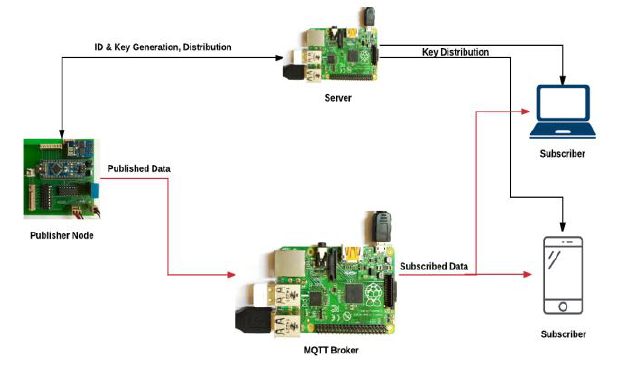
Figure 4. Experimental